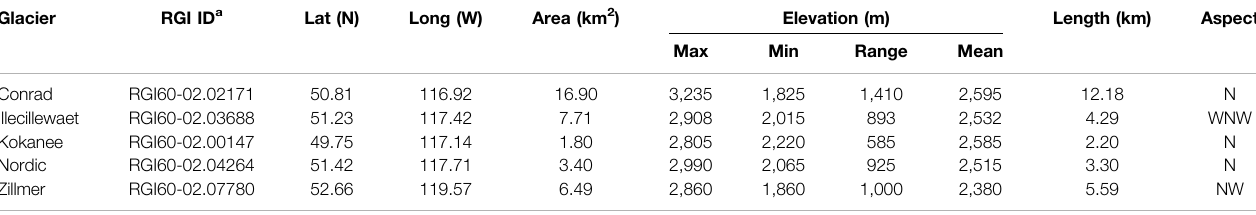
TABLE 1 | Characteristics of study glaciers as of 2015. Glacier RGI ID a Lat (N) Long (W) Area (km 2 ) Length (km) Aspect